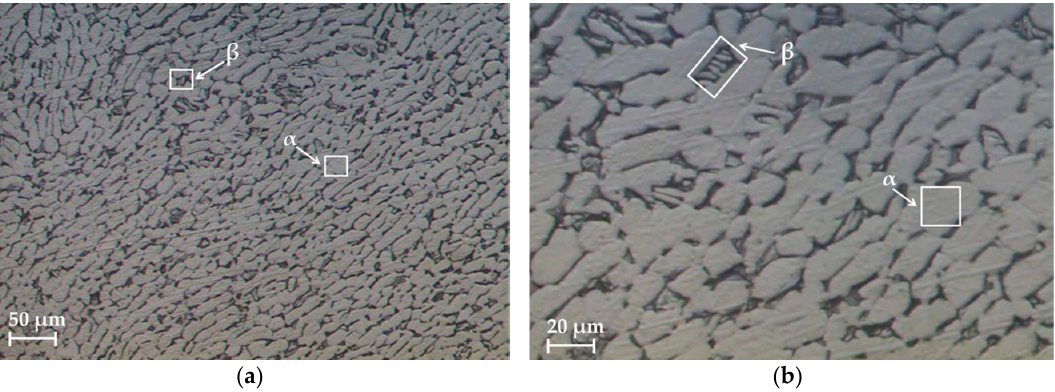
Figure 1. ( a ) Stereoscopic optical microscopy (SOM) images of the microstructure of the tested Ti6Al4V alloy and ( b ) amplification and identification of α and β